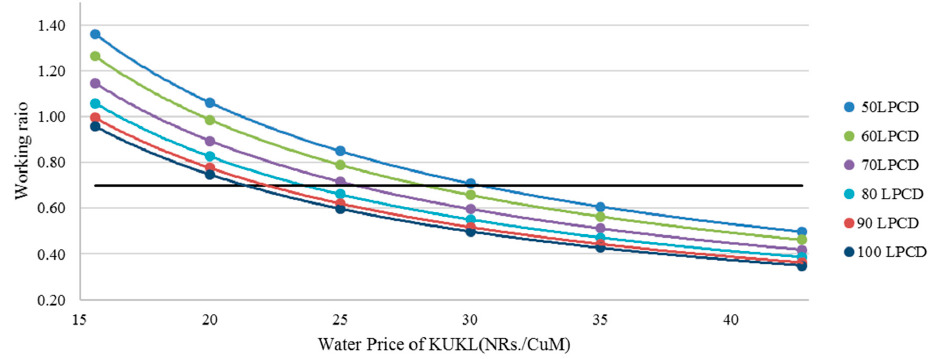
Figure 5. Comparison of working ratio with water price at various minimum water use scenarios.